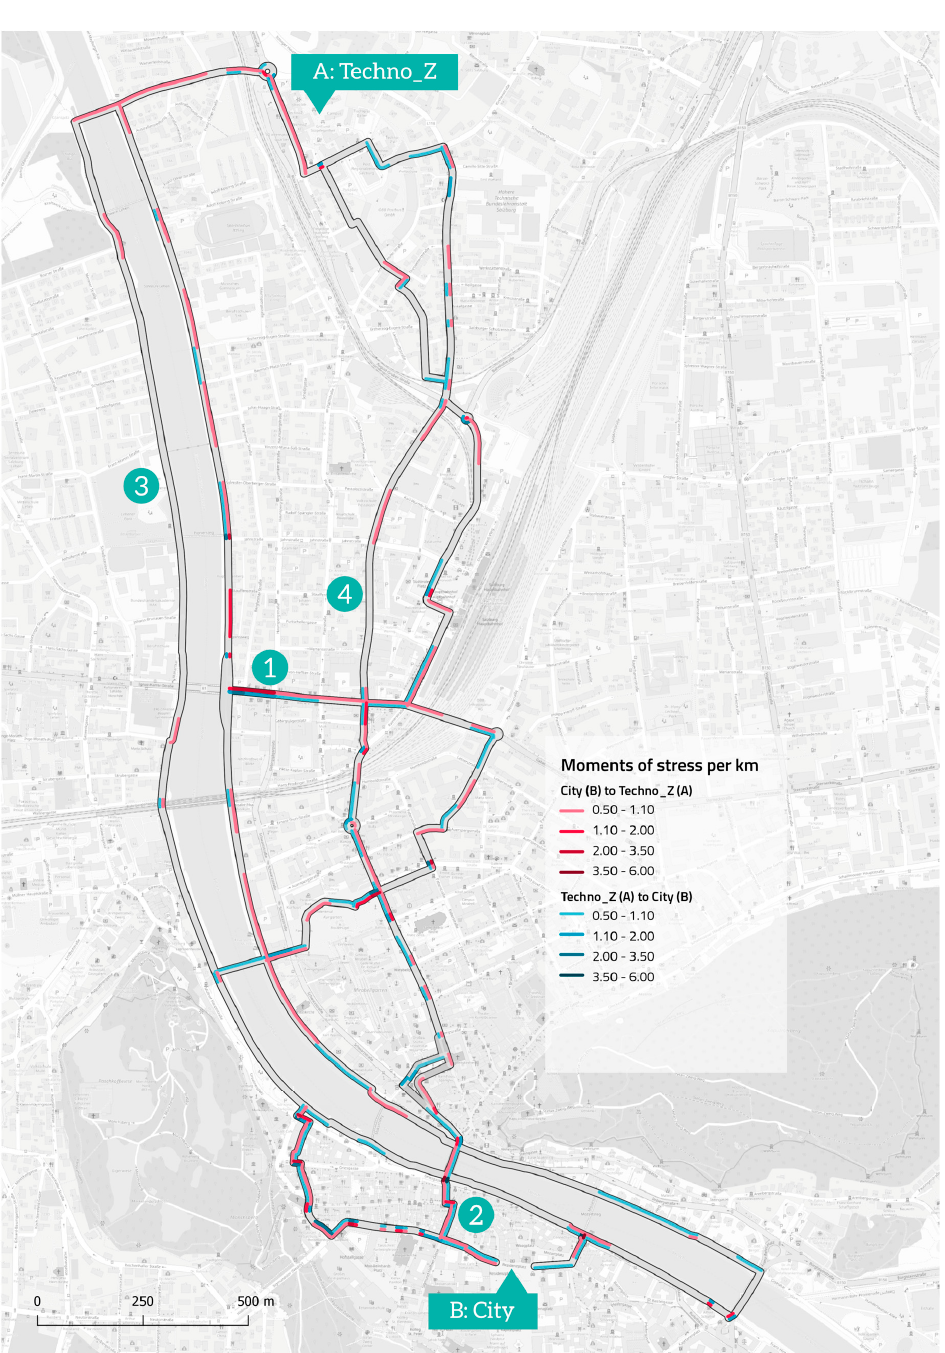
© OpenStreetMap contributors,